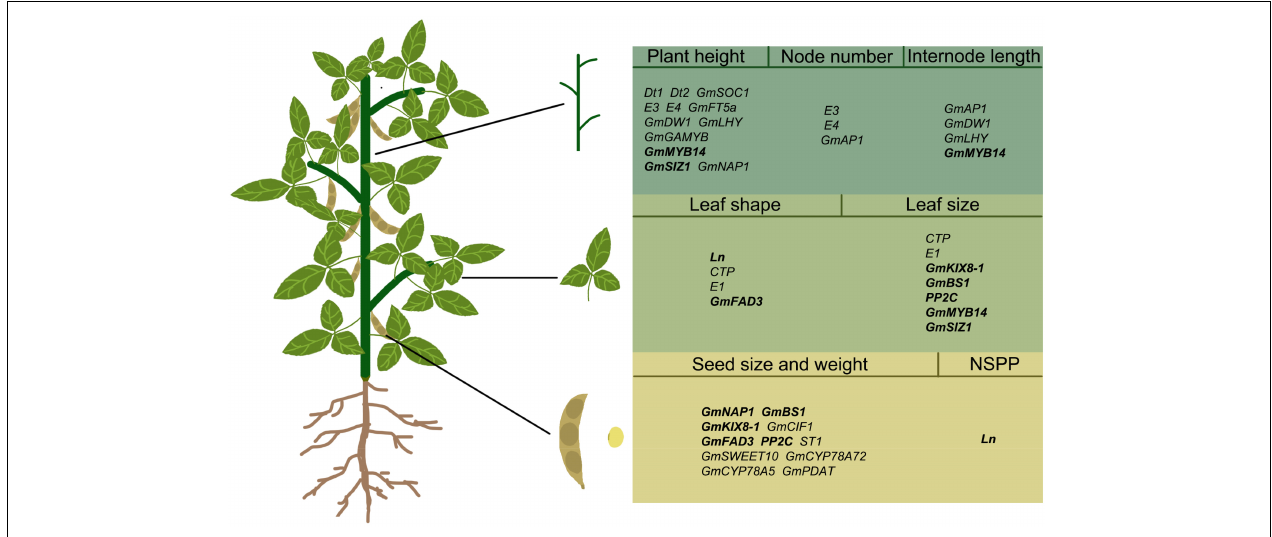
FIGURE 2 | Regulatory genes in different organs of soybean. The words in bold refer to genes that simultaneously regulate the morphology of two soybean organs. Simultaneous regulation of stem and leaf: GmMYB14 and GmSIZ1 ; Simultaneous regulation of leaf and seed: Ln , GmKIX8-1 , GmBS1 , GmFAD3 , PP2C ; NSPP, number of seeds per